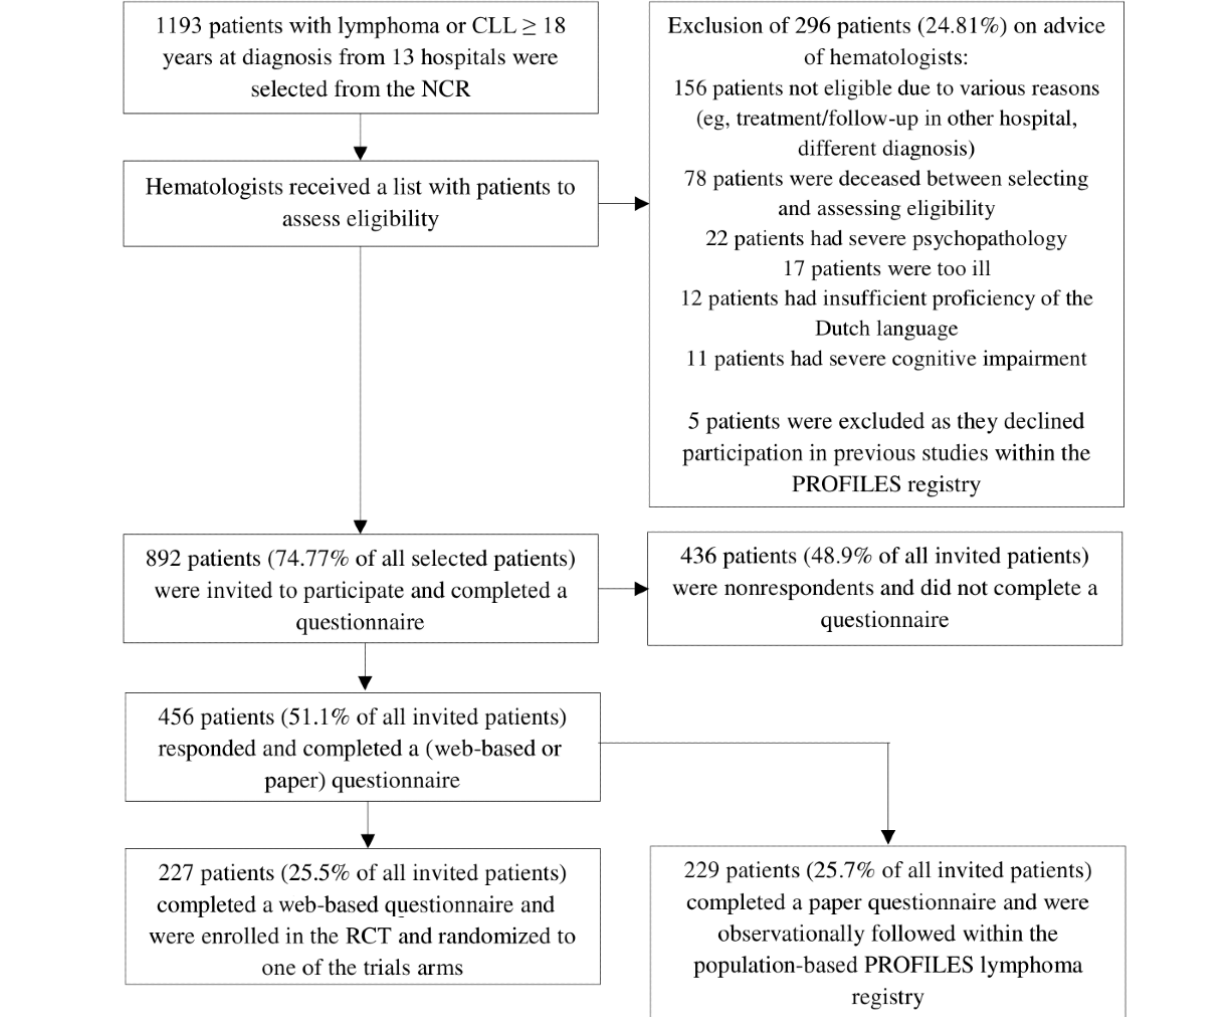
Figure 1. Flowchart of the data collection process. CLL: chronic lymphocytic leukemia; NCR: Netherlands Cancer Registry; RCT: randomized controlled trial; PROFILES: Patient Reported Outcomes Following Initial treatment and Long term Evaluation of